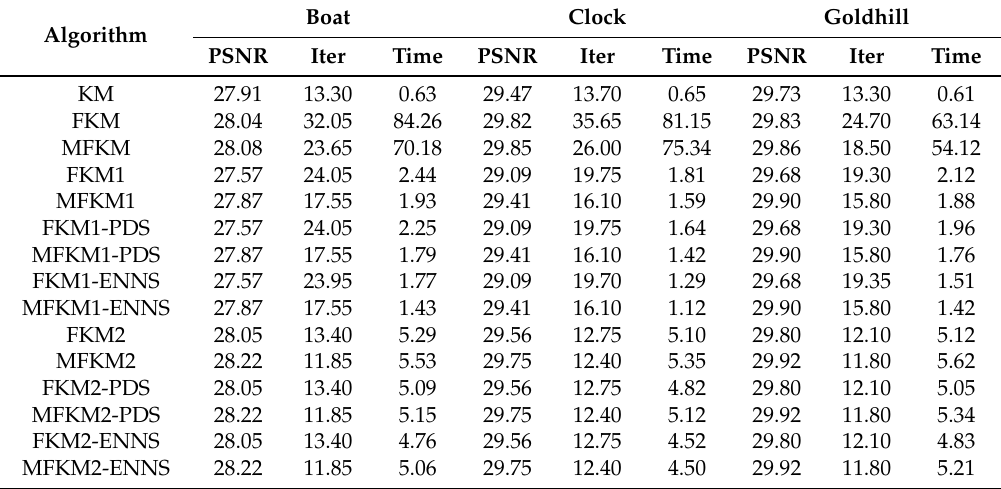
Table 9. PSNR (in dB), number of iterations and codebook design time (in seconds) for images Boat, Clock and Goldhill, using N =